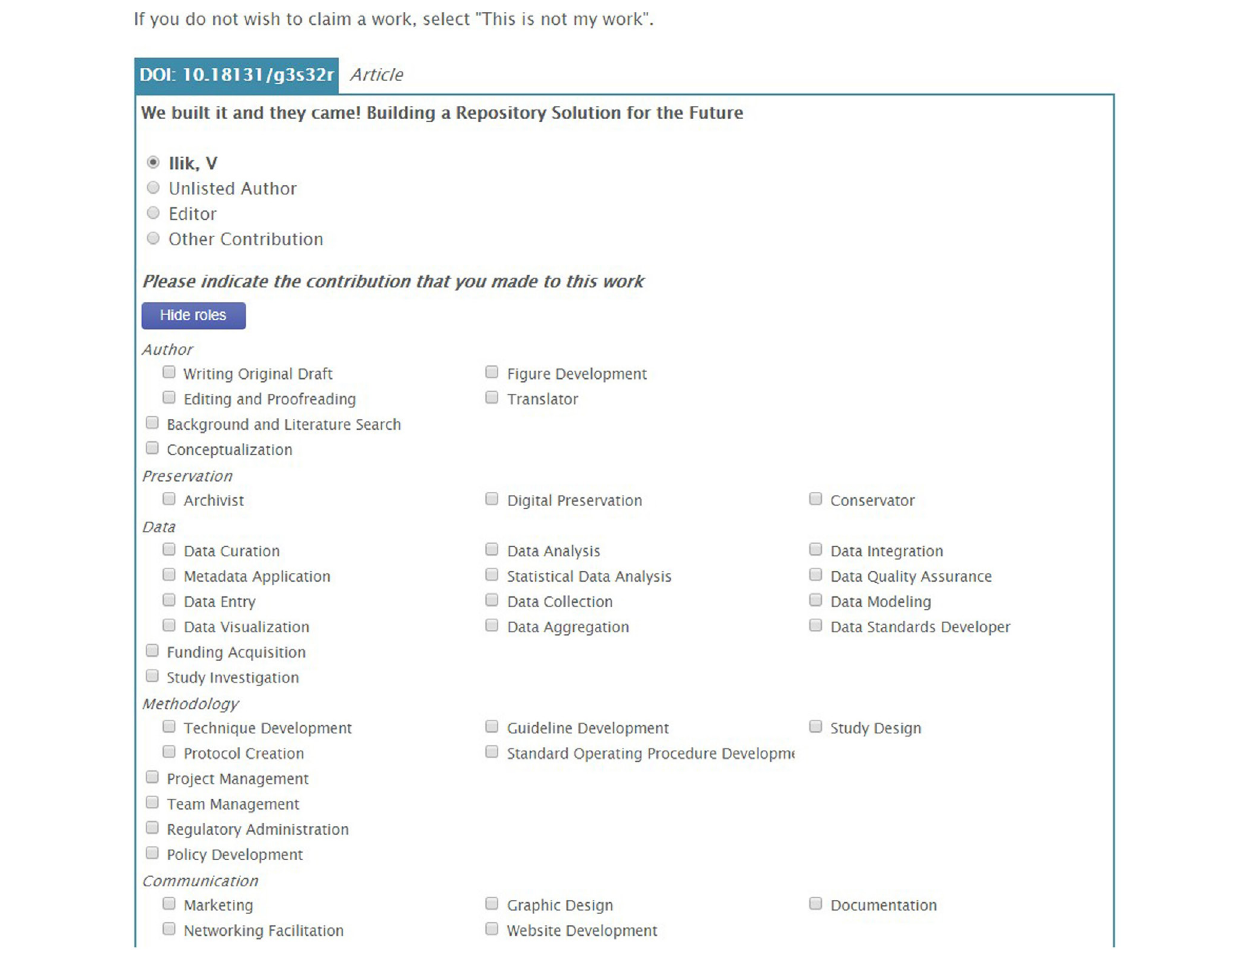
FIguRe 5 | The claim process. Once metadata have been retrieved for an identified work, the user is asked to confirm their author position—OpenVIVO attempts to guess from the metadata—and/or assign any contribution